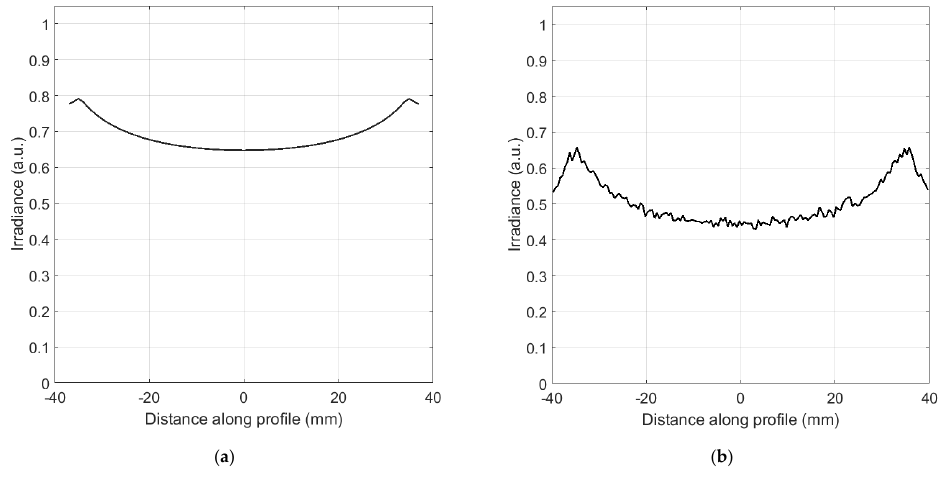
Figure 9. Central irradiance profile of distributions of Figure 8: ( a ) flowline computation; ( b ) raytrace